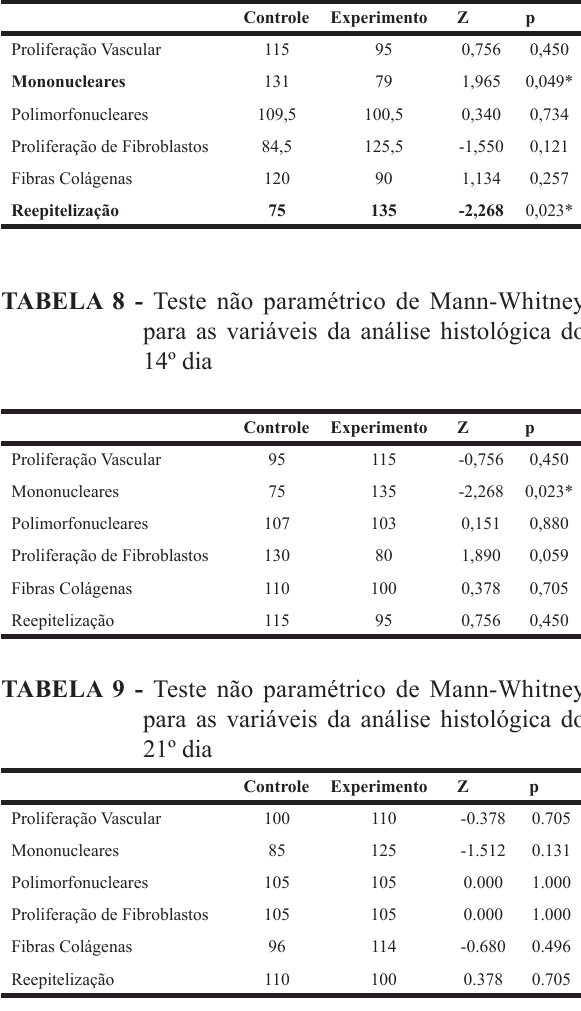
FIGURA 8 - Interação entre dias e grupos média das áreas dos Dias e dos Grupos. Legenda: F= Significância da interação, p= Nível de significância TABELA 7 - Teste não paramétrico de Mann-Whitney para as variáveis da análise histológica do 7º dia